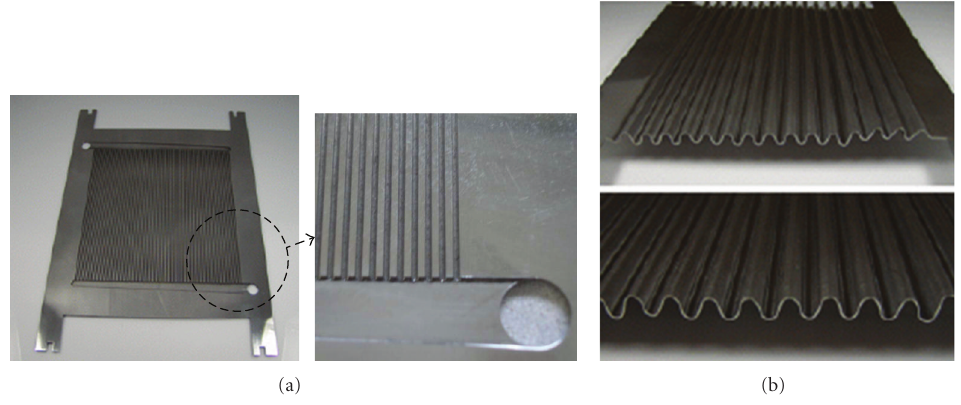
Figure 3: Flow plates of plate-type PHE prototypes: (a) primary flow plate and (b) secondary flow plate.